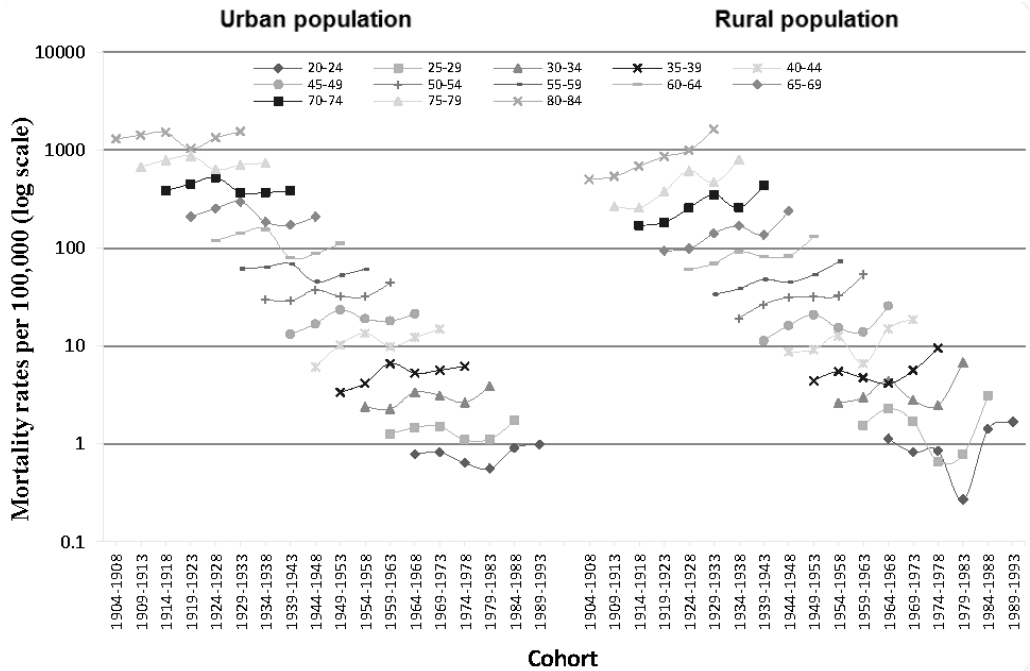
Figure 4. Cohort-specific IHD mortality rates in urban and rural China, by age group.